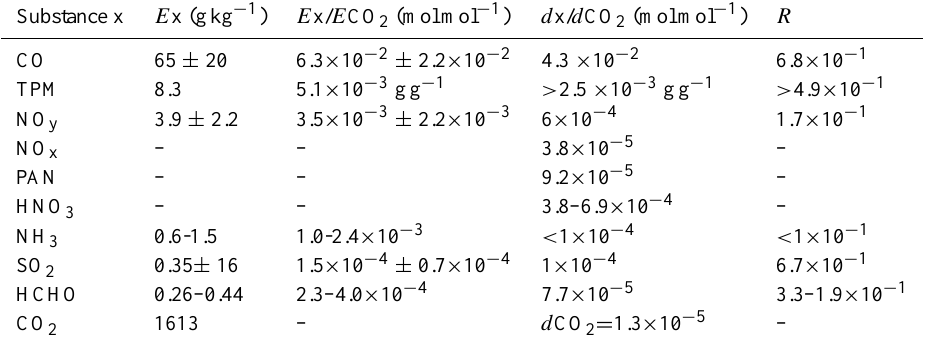
Table 1. Emission factors Ex, molar emission ratios E x/ E CO 2 (adopted from Andreae and Merlet, 2001) and the measured excess molar emission ratio d x/ d CO 2 . The last column denoted with R gives the ratio between d x/ d CO 2 and E x/ E CO 2